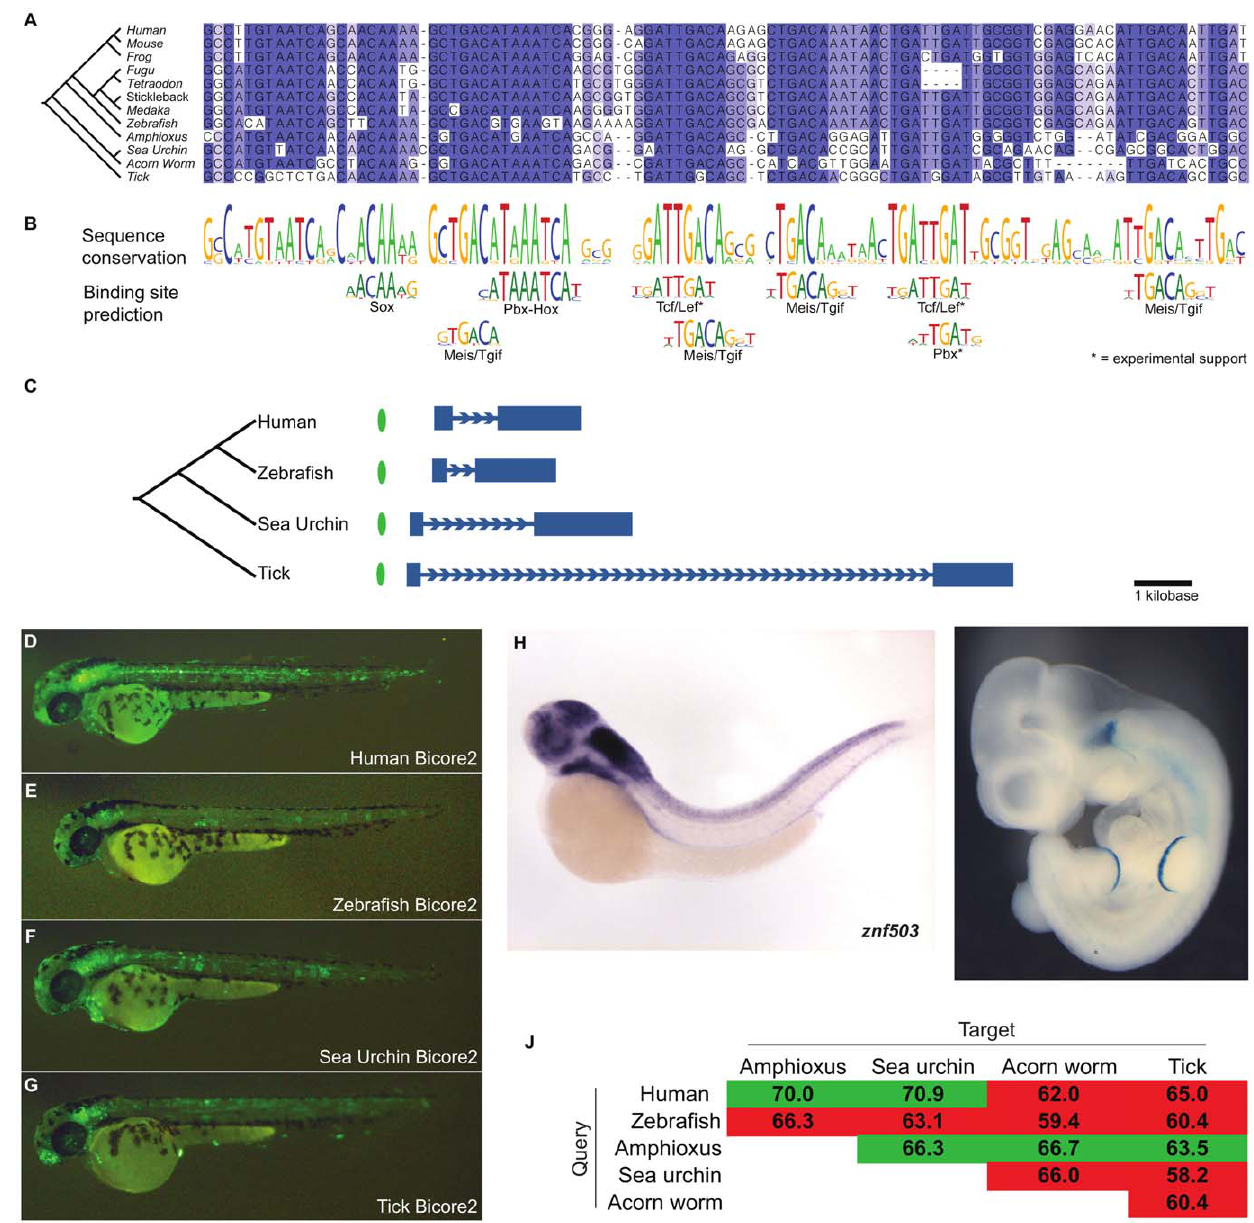
Figure 4. Bicore2 is a bilaterian conserved enhancer. (A) Multiple alignment of Bicore2. (B) Conservation profile of Bicore2 showing that conserved blocks in the alignment correspond to transcription factor binding preferences. (C) Each instance of Bicore2 (green oval) is syntenic to a conserved instance of Znf503 (blue gene structure). (D–G) Zebfrafish transgenic enhancer assay showing (D) human, (E) zebrafish, (F) sea urchin, (G) tick instances of Bicore2 drive expression in the hindbrain at 48 hours. (H) Whole-mount in situ hybridization of Znf503 shows expression in the hindbrain, courtesy of zfin.org. (I) A human region containing Bicore2 drives expression in the hindbrain and the apical ectoderm of the limb in embryonic day 11.5 mice. (J) Pairwise percent identities of Bicore2 sequences. Green cells indicate a query sequence (row) that detected Bicore2 in the target (column). Red cells indicate query sequences that did not detect Bicore2 in the target.